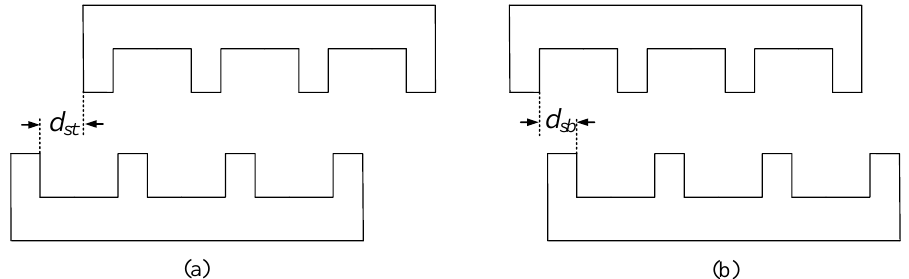
Figure 7. Stator tooth displacement variables: ( a ) Top stator tooth displacement; ( b ) Bottom stator tooth displacement.